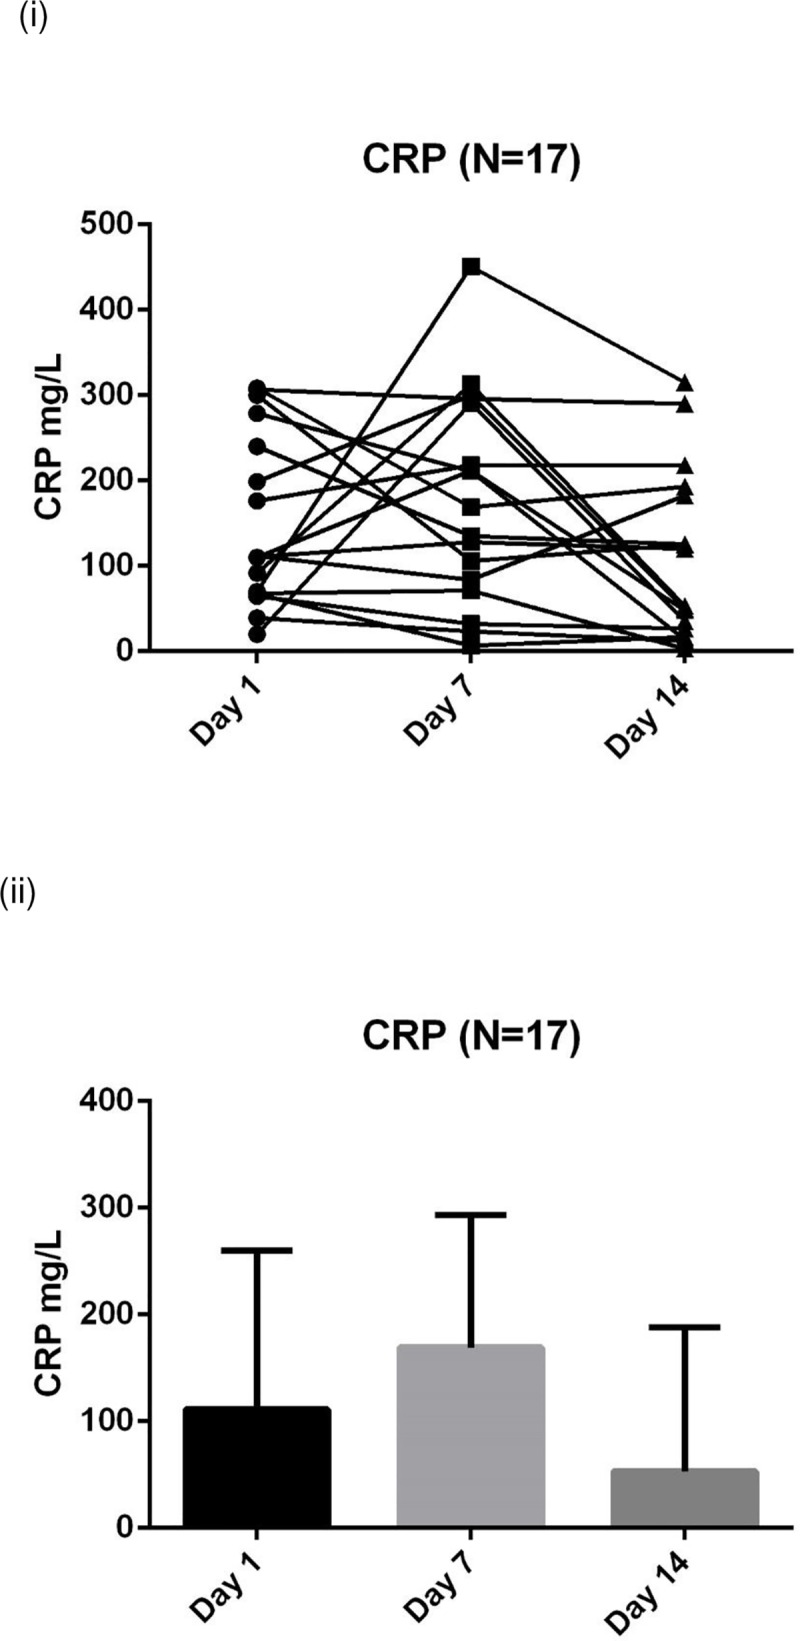
Serial CRP (N = 17) measurements in long stay patients: (i) Plots to explore individual variability (ii) Box plots reported with median and IQR.* CRP: C-reactive protein. Medians and IQR are reported in the S1 Table (a), not on this figure due to wide variance.